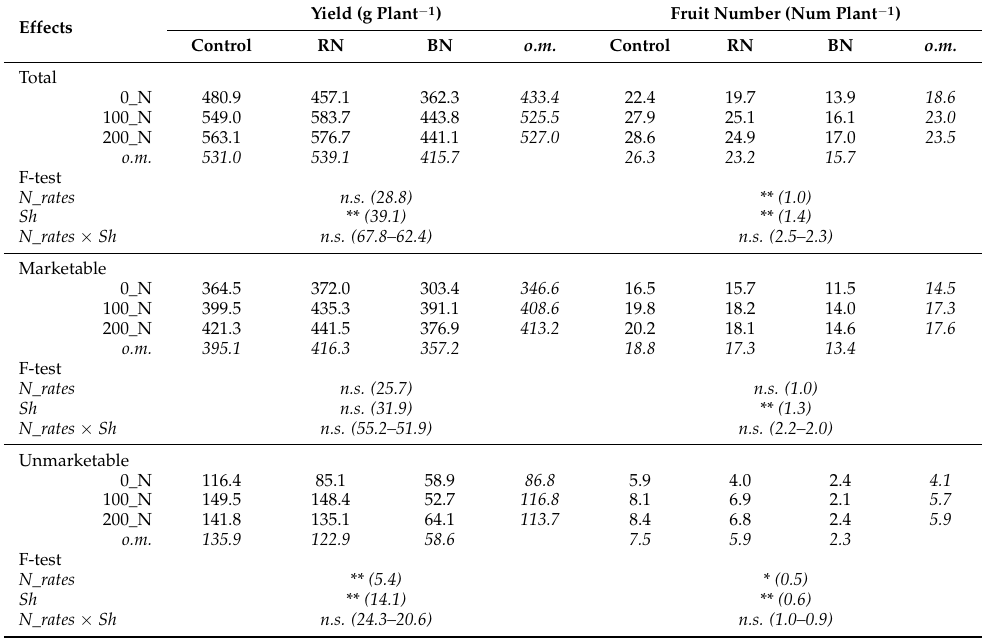
Table 1. Yield (total, marketable and unmarketable; g plant − 1 ) and yield parameters (num fruits plant − 1 ) as recorded in pepper plants subjected to different N fertilization rates (N_rates; plished using: no cover, Control; red photoselective net, RN; black photoselective net, BN) in 2017 a . Unmarketable yields and number of fruits included both sunscalded fruits and fruits characterized by other physiological or not-physiological disorders, green and undersized